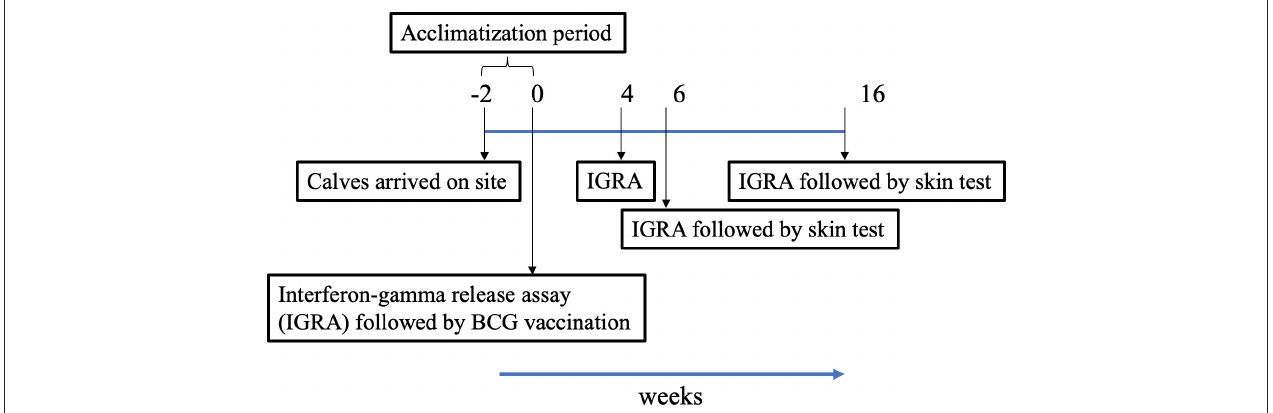
FIGURE 1 | Timeline chart. Following arrival of calves on site, they were acclimatized for a period of 2 weeks. Vaccination of calves at week 0 denotes start of trial. Blood was collected for Interferon-gamma release assay (IGRA) just prior to injection of BCG, and at weeks 4, 6, and 16 post-vaccination. Skin tests were conducted at weeks 6 and